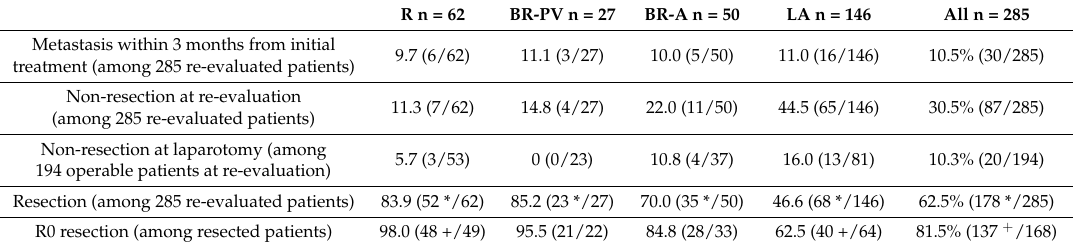
Table 2. Clinical outcomes of CRTS in the re-evaluated 285 PDAC patients according to resectability groups. R n = 62 BR-PV n = 27 BR-A n = 50 LA n = 146 All n = 285 Metastasis within 3 months from initial treatment (among 285 re-evaluated